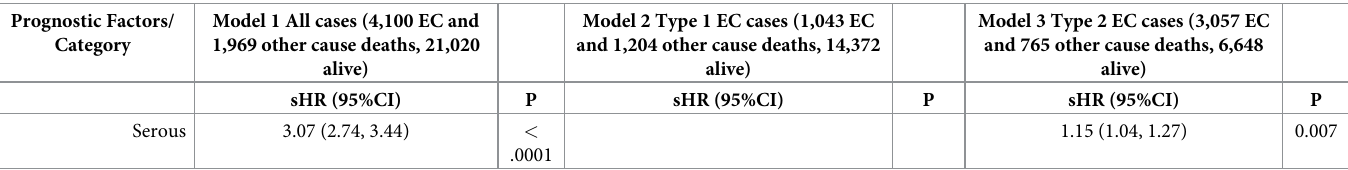
incidence of EC death by type 2 EC histological subtype. For the carcinosarcoma subtype, the cumulative incidence of EC death reached nearly 60% at 10 years.